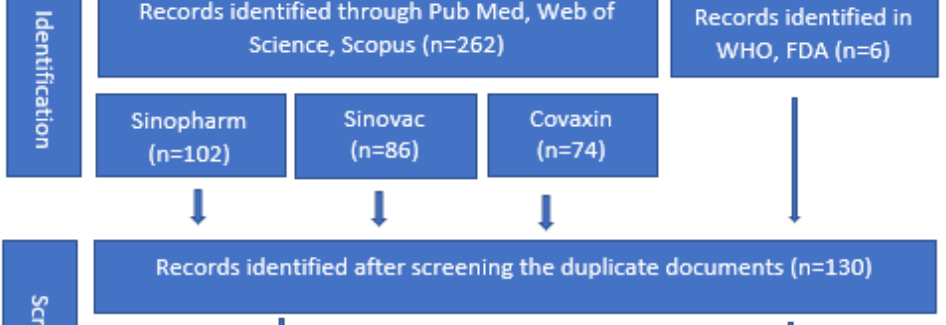
Figure 1. PRISMA flow diagram for the selection of fact sheets and documents about Sinopharm, CoronaVac, and Covaxin COVID-19 vaccines.